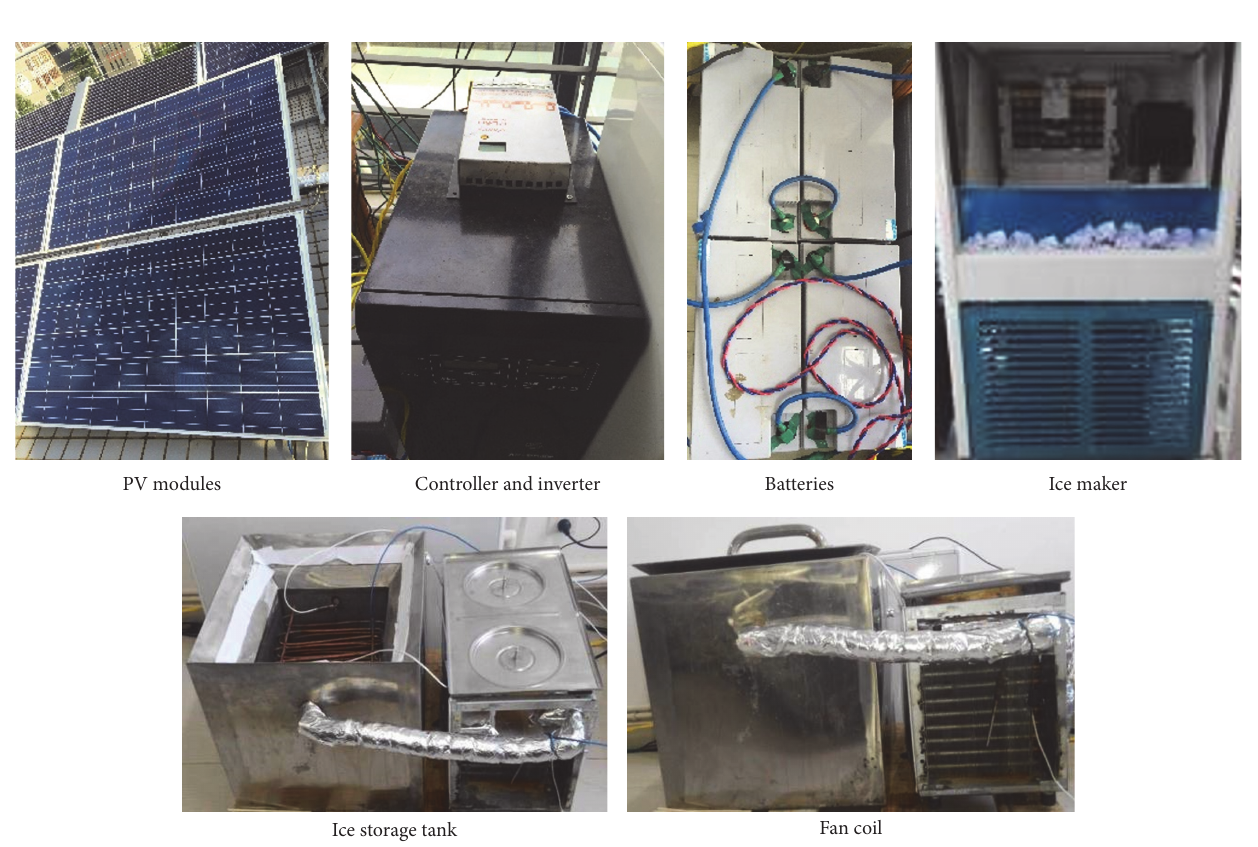
Figure 2: Pictures of 0.2 kW ISACS driven by